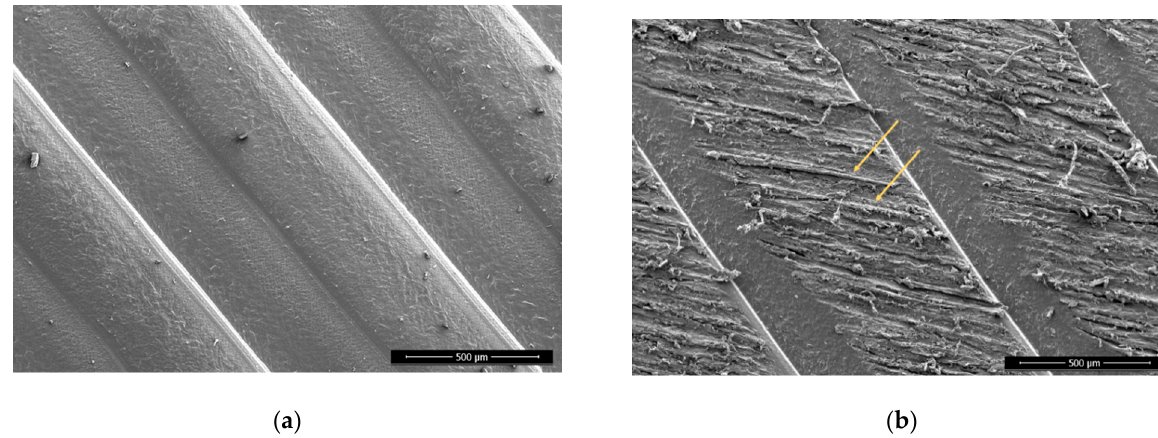
Figure 3. PLA, non-sanded, non-treated ( a ) and, sanded, non-treated, with visible sanding traces; ( b ) 100× magnification.